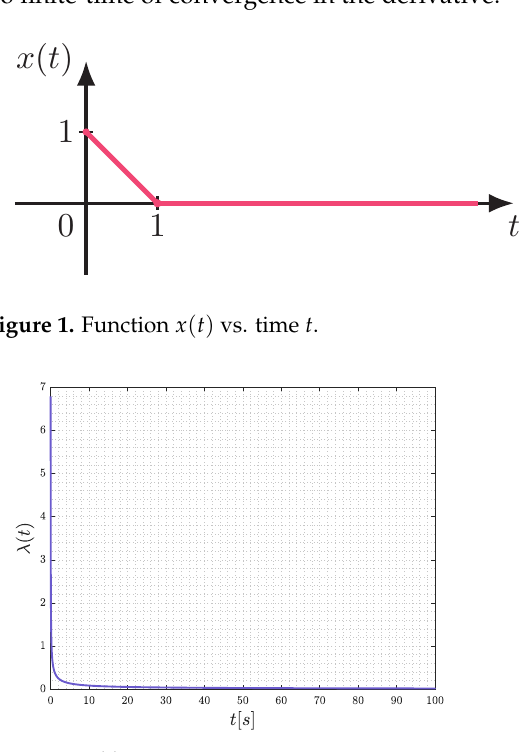
Figure 2. λ ( t ) (Equation (42)) with α = 0.65, β = 0.5, and γ = −